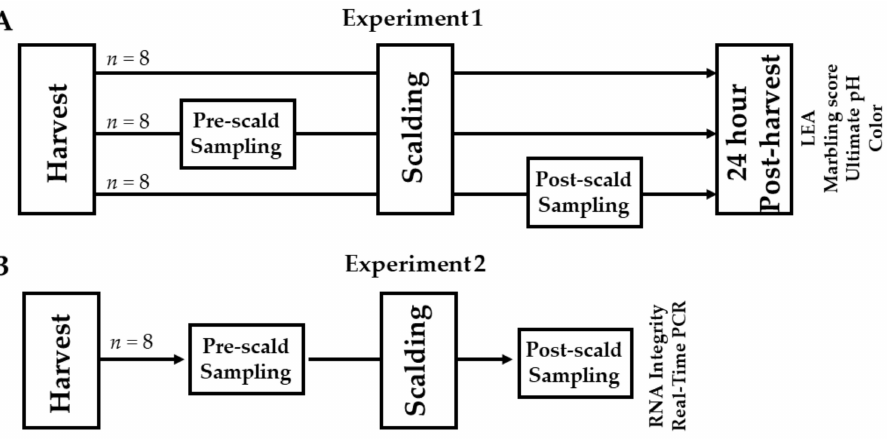
Figure 1. Schematic depicting the experiment design for experiment 1 ( A ) and experiment 2 ( B